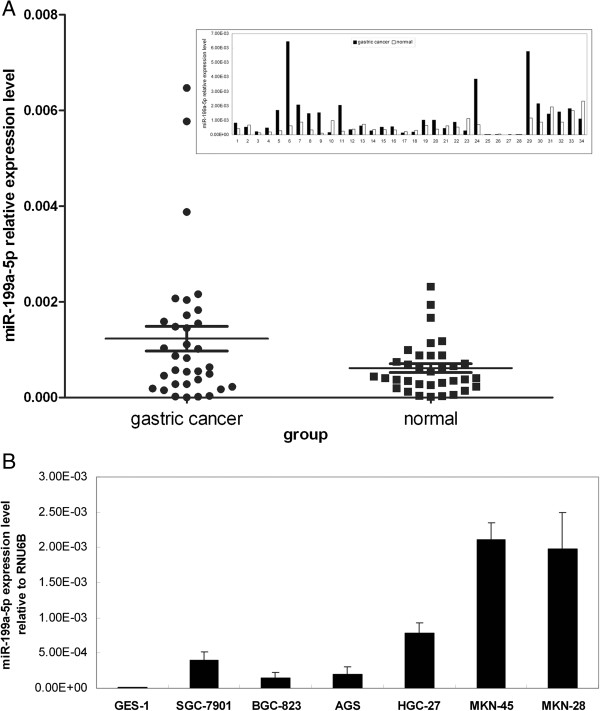
The expression level of miR-199a-5p in GC tissues and gastric cancer cell lines examined by qPCR. (A) Expression level of miR-199a-5p was higher in 34 GC tissues than in their pair-matched adjacent normal tissues (P < 0.05). Each sample was analyzed in triplicate and normalized to RNU6B. (B) The relative miR-199a-5p expression in gastric cancer cell lines was much higher than that of GES-1. The relative expression of miR-199a-5p was normalized to the endogenous control RNU6B. Each sample was analyzed in triplicate.